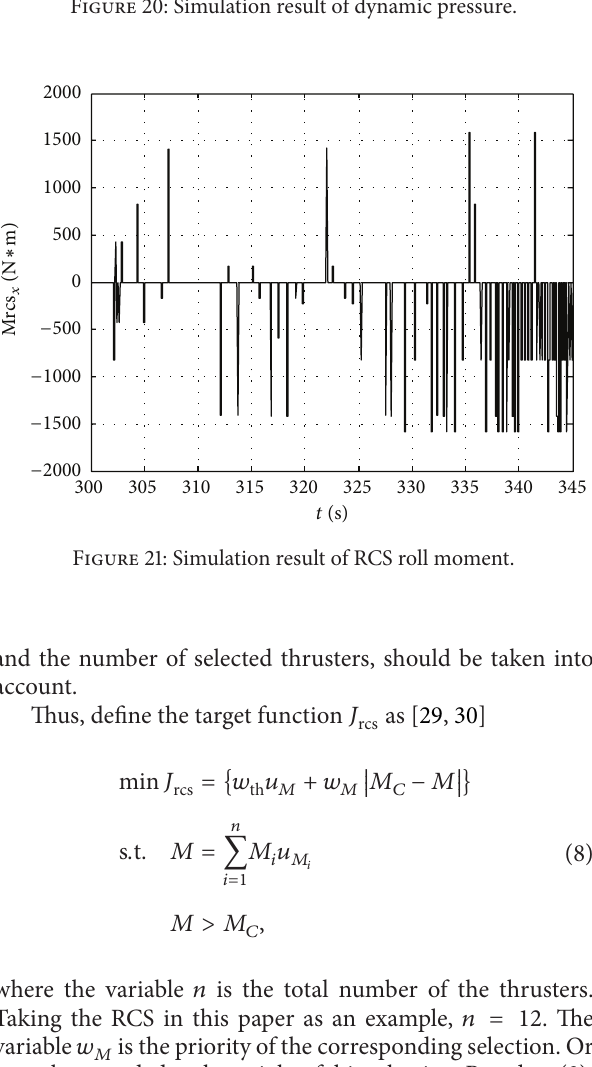
Figure 20: Simulation result of dynamic pressure.